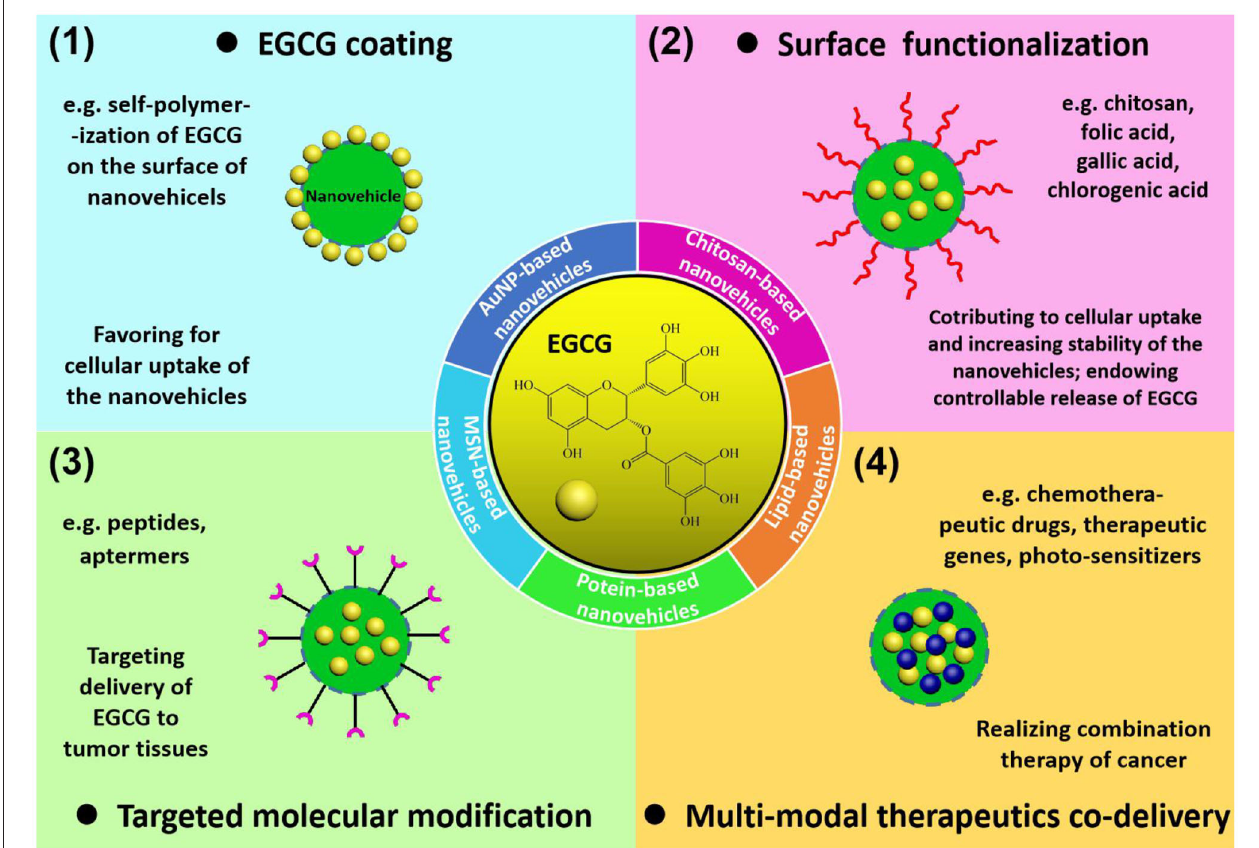
FIGURE 1 | Summary of EGCG delivery systems: (1) grafting EGCG on the surface of the nanoparticles to enhance cellular uptake of as-obtained nanovehicles; (2) surface functionalization with specific molecules (chitosan, folic acid, gallic acid, and chlorogenic acid) to enhance stability, cellular uptake, and drug release properties of the nanovehicles; (3) targeted molecular modification by peptides or aptamers to target specific cancer cell receptors; (4) construction of multi-modal therapeutics co-delivery systems to realize EGCG-involved cancer combination